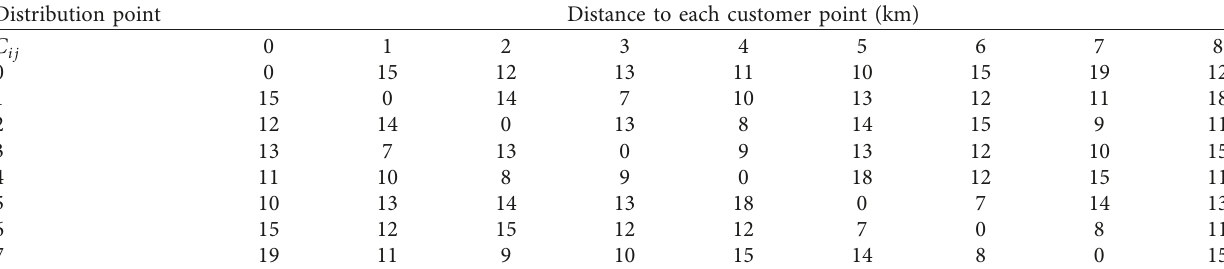
Figure 3: The schematic diagram of model simulation. Table 1: Distance of each customer point.